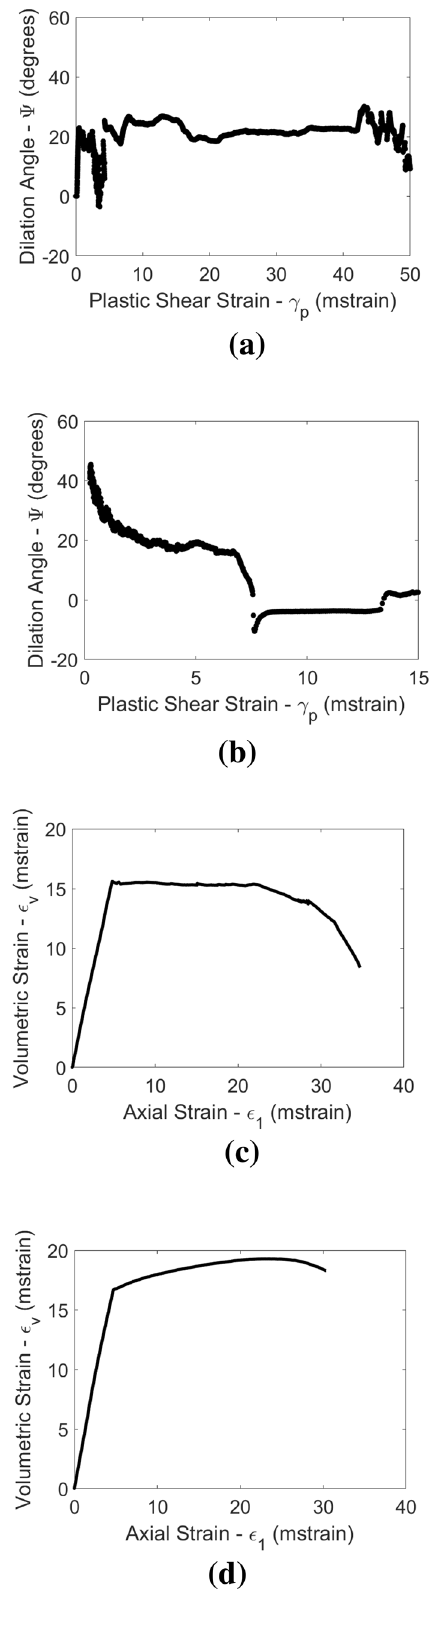
b Fig. 8 Dilation angles as a function of plastic shear strain (top) and volumetric-axial strain plots (bottom) for 30 (cid:3) included angle speci- mens tested at 40 MPa (left) and 64 MPa (right) of